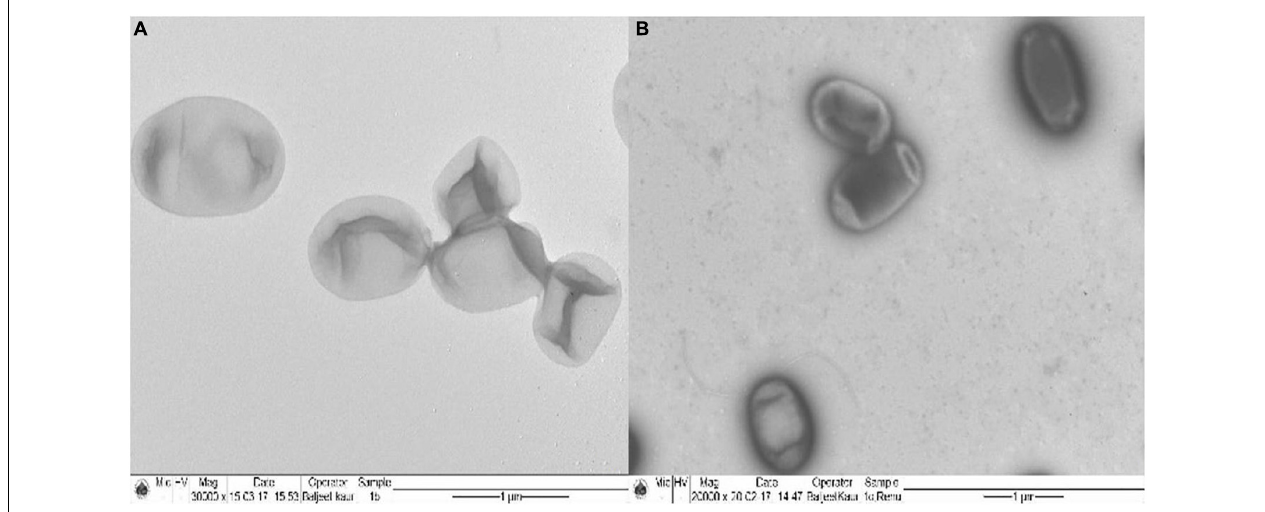
FIGURE 5 | Principal component analysis (A) and clustering analysis (B) showing the impact of 25, 50, and 75 mg L − 1 Cd concentration on various PGP traits of O. intermedium BB12 in the culture media. Mean of PCA-axis values ± SD ( n = 3, p < 0.05).